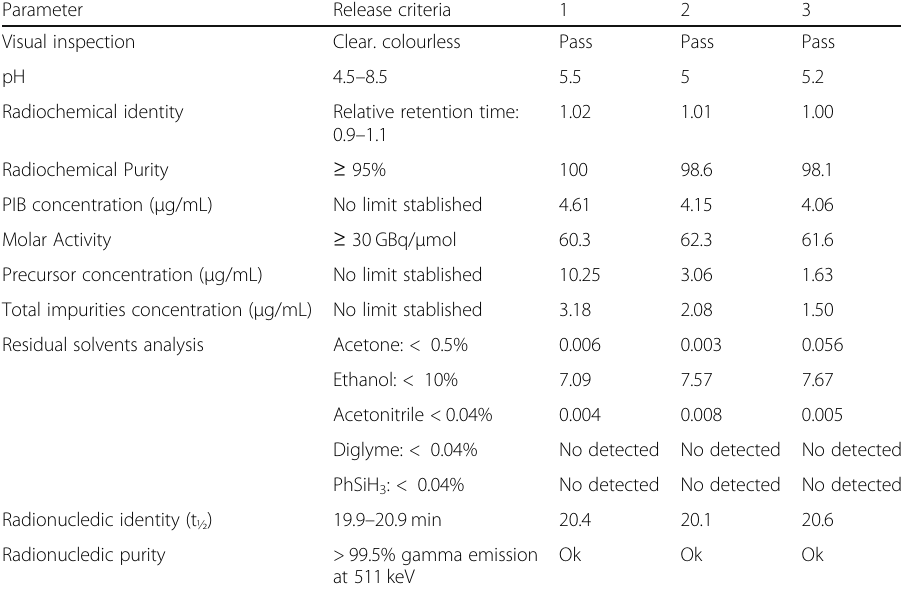
Table 3 Physicochemical quality control parameters for three consecutive batches of [ 11 C] PiB (labelling time 1 min) Parameter Release